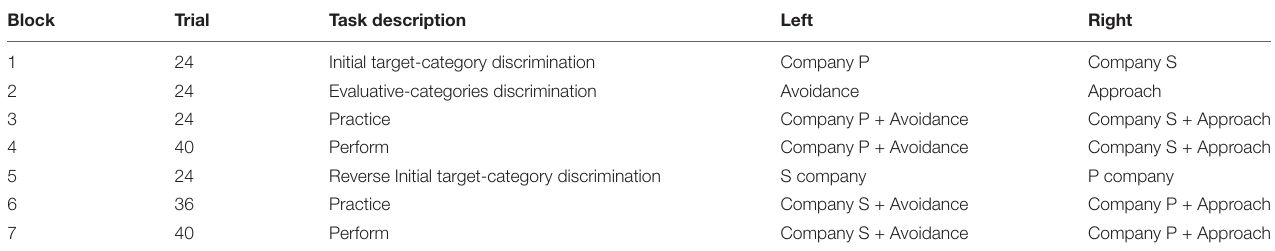
TABLE 2-2 | Procedure of IAT.